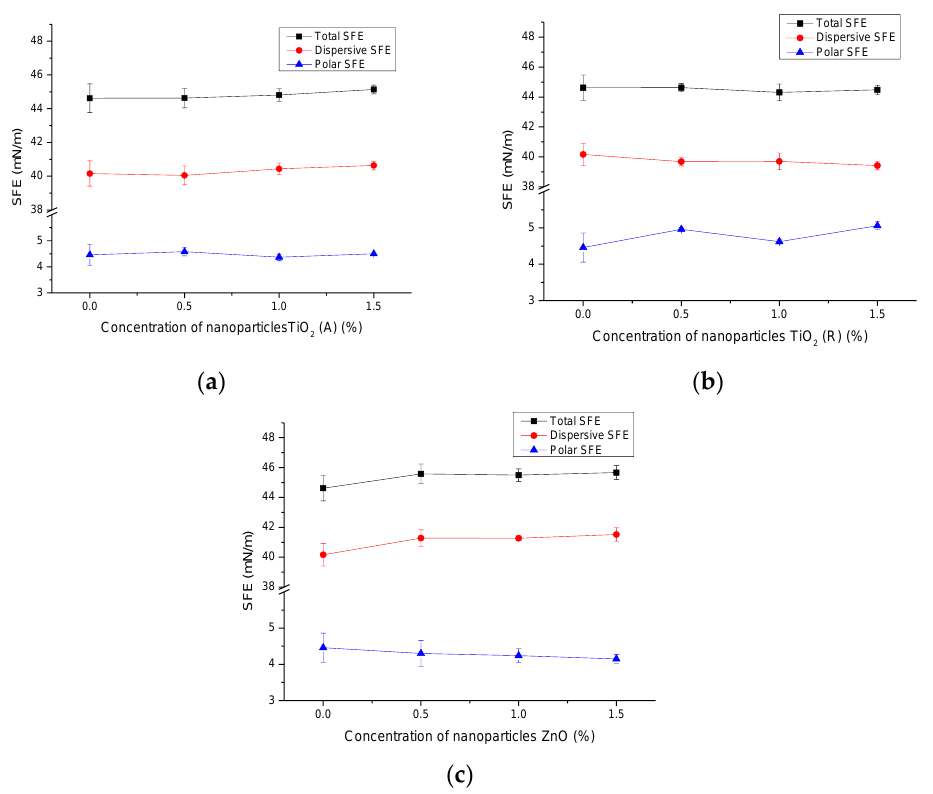
Figure 4. SFE of coated paperboards with deposited ink films without, and with the addition of nanoparticles; ( a ) TiO 2 (A), ( b ) TiO 2 (R), and ( c ) ZnO.